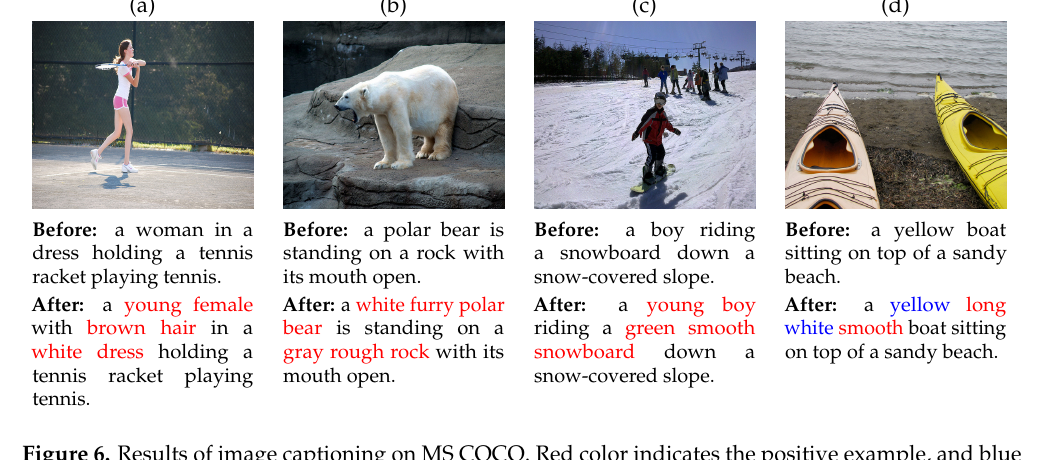
Figure 6. Results of image captioning on MS COCO. Red color indicates the positive example, and blue color indicates the negative example.